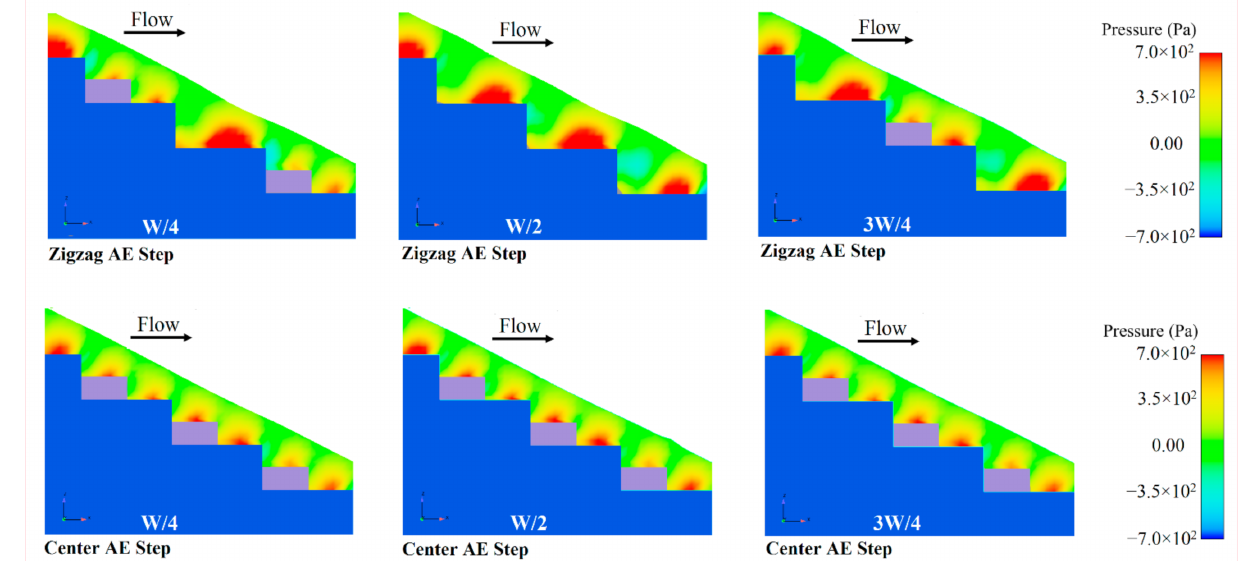
Figure 11. Pressure contour for different pool configurations